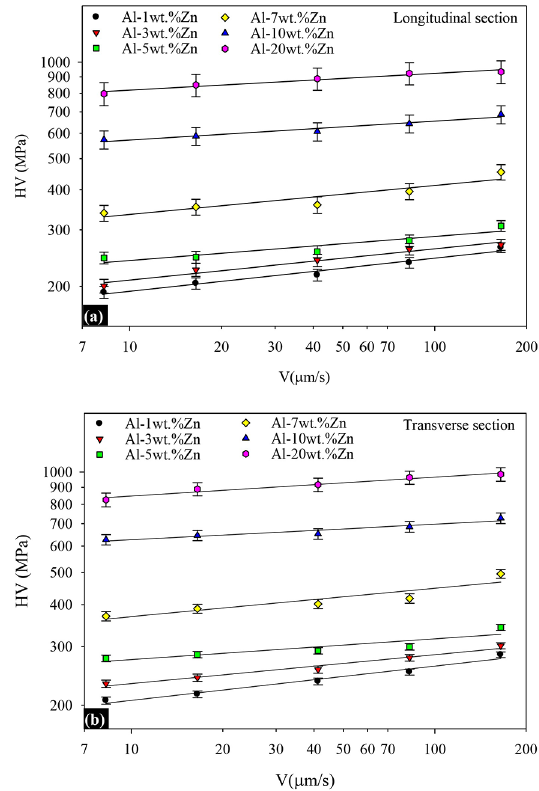
Figure 6. The variation of microhardness with growth velocity for different Al-Zn compositions (a) Longitudinal section (b) Transverse